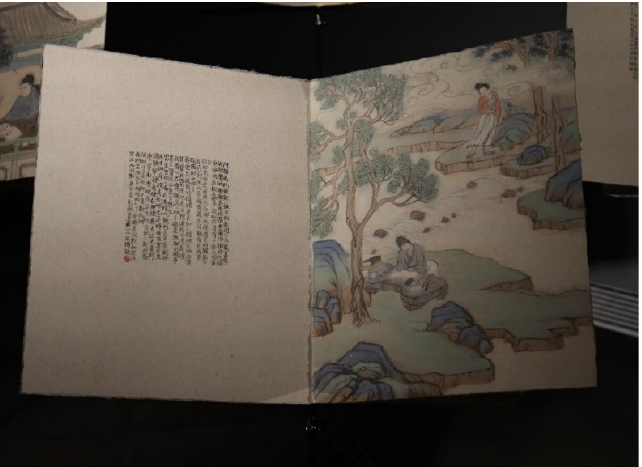
Figure 7. “Xiaoxiao Su in the ‘The One in My Dreams’”, partially enlarged. One of the “Dreamer” series by Wei Peng, 2019. Ink on paper, painting installation. Picture from the Center for Visual Studies, Peking University.